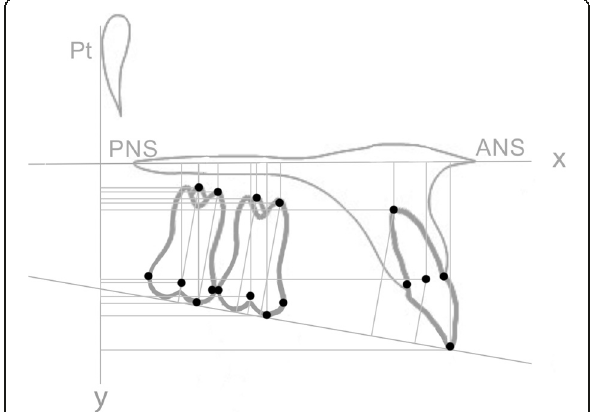
Fig. 2 Schematic Illustration of angular measurements (°) of maxillary second molar (1), maxillary first molar (2), and central incisor (3). The angle between the tooth long axis (passing trough the mesiobuccal cusp and mesiobuccal root ’ s apex for the first and the second molar; passing trough the incisal edge and root ’ s apex for the central incisor) and x axis (palatal plane) expressed the inclination of the tooth